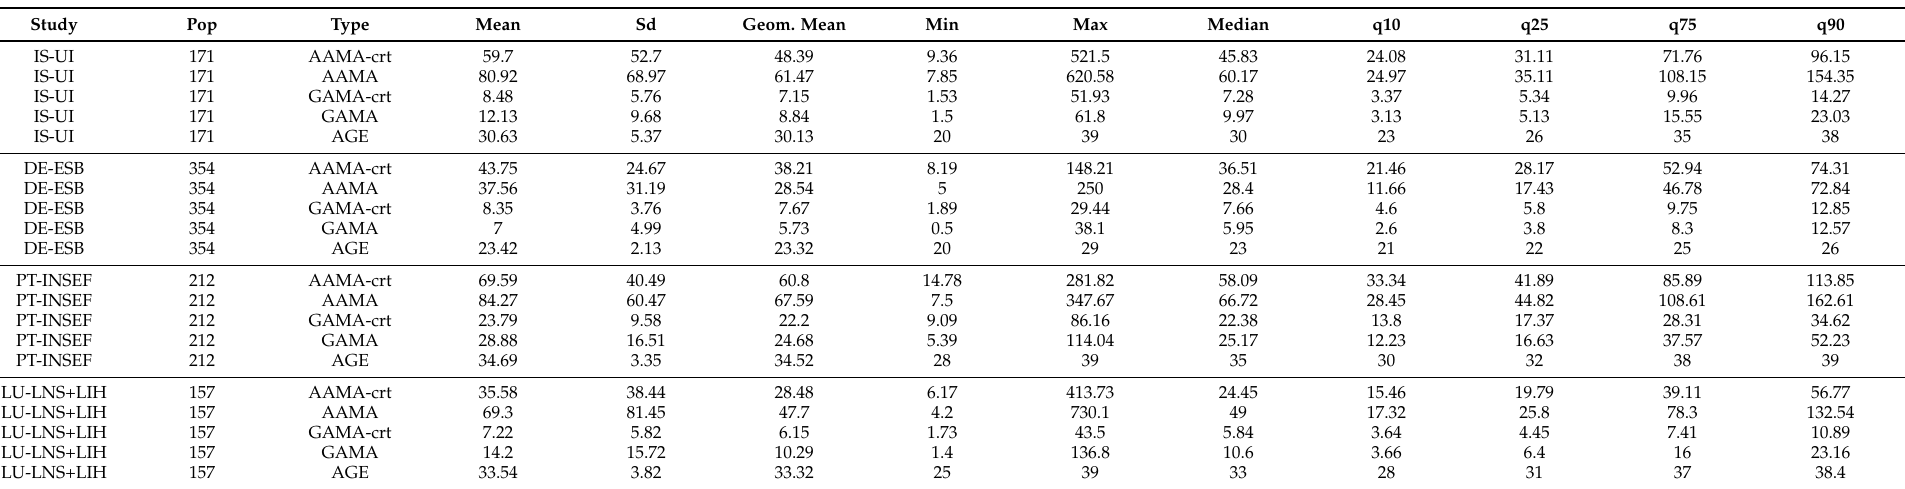
Table A3. Descriptive statistics of acrylamide biomarker levels per study (non-smoker I).